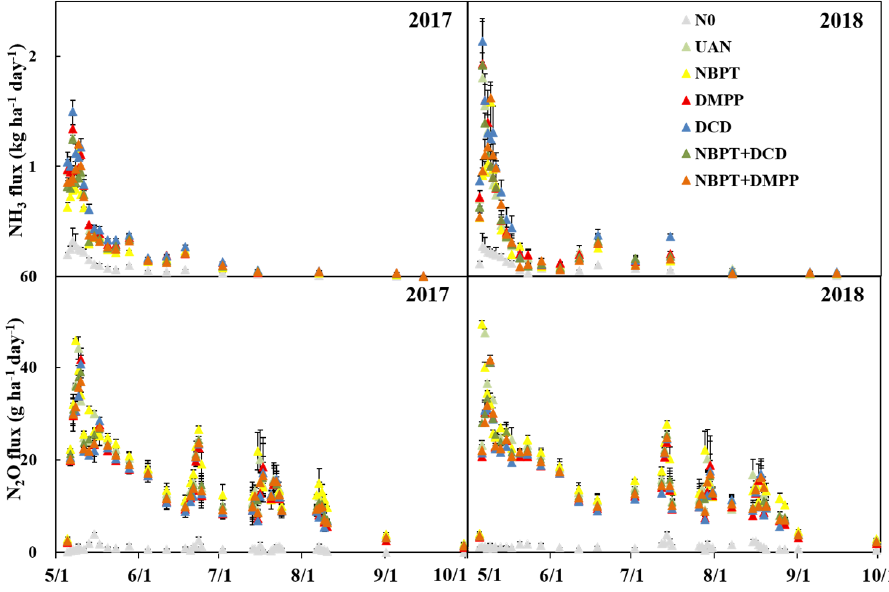
Figure 3. NH 3 flux and N 2 O after fertilization, bars are standard error of the mean.